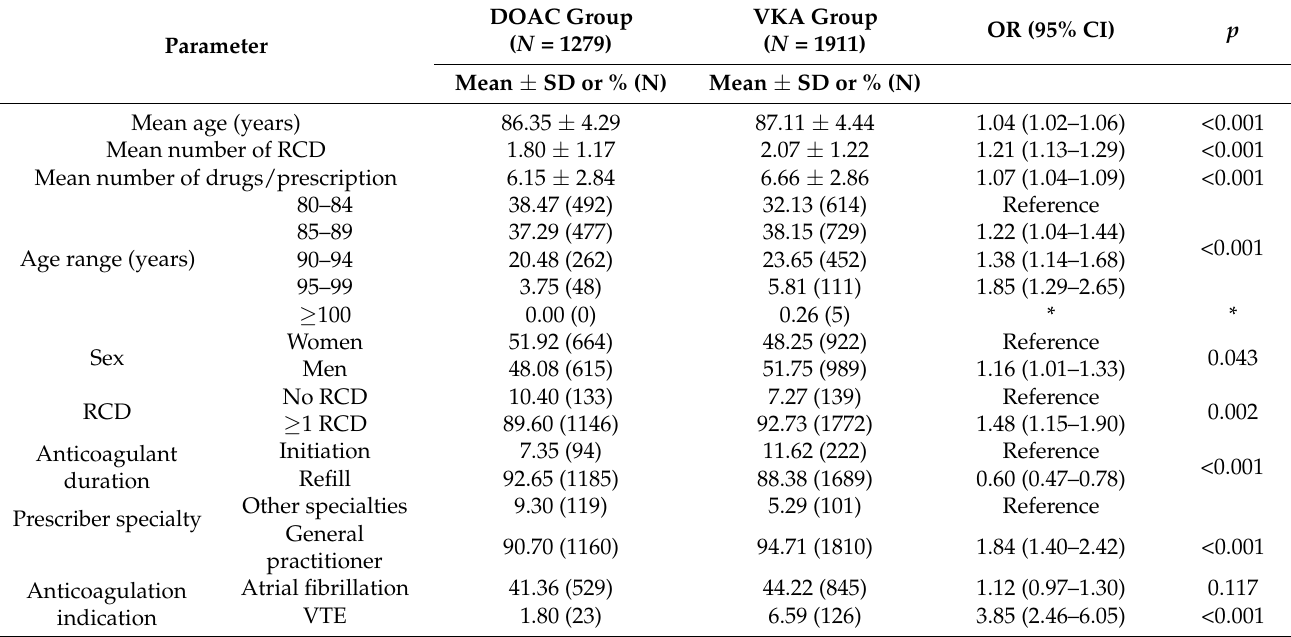
Table 1. Comparison of age, sex, existence of one or more registered chronic diseases (RCD), anticoagulant prescription duration, medical specialty of the prescribing physician, rates of AF and VTE, mean number of RCDs, and mean number of drugs per prescription between subjects prescribed direct oral anticoagulants or vitamin K antagonists, using bivariate analysis by logistic